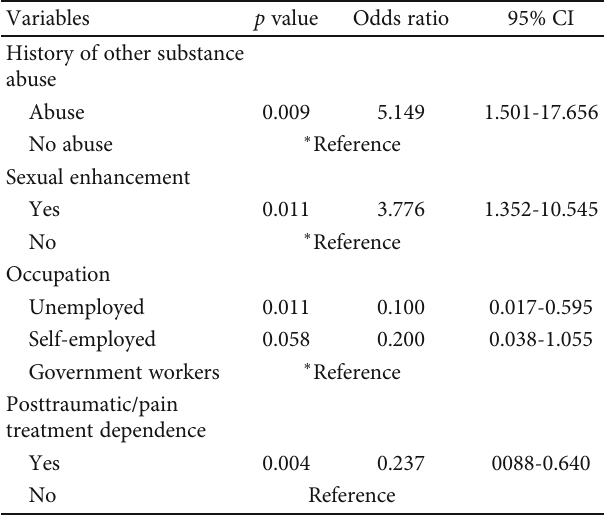
Table 8: Determinants of tramadol abuse/misuse among the